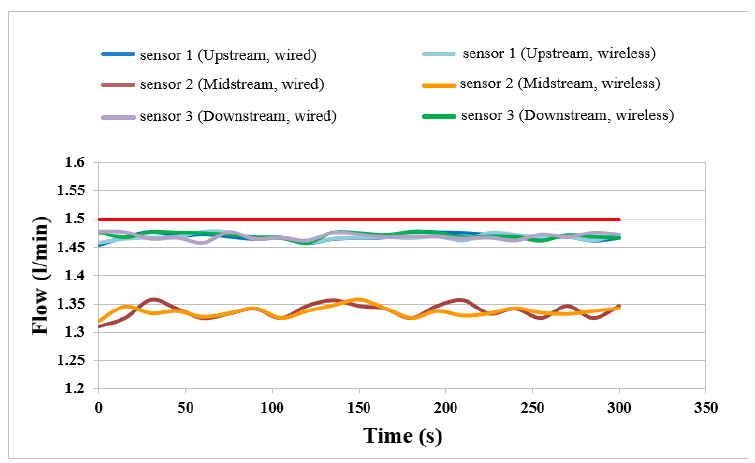
Figure 11. Flow distributions of external, wired and wireless sensors.